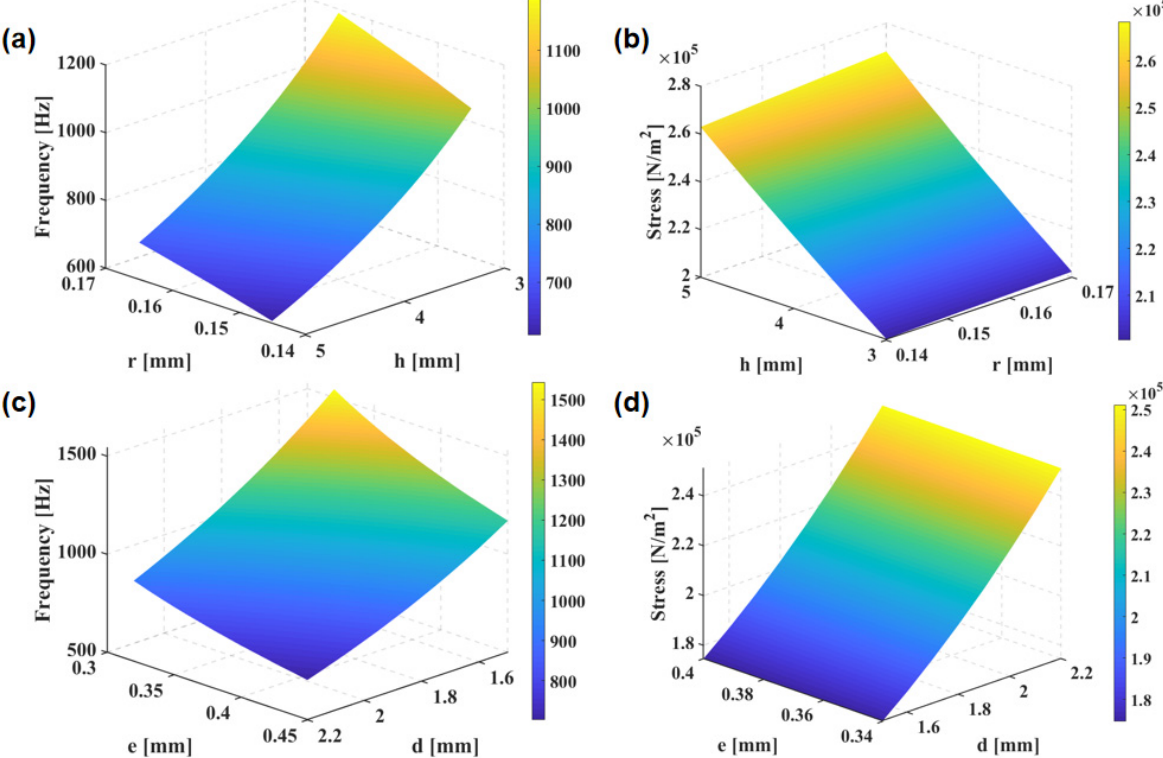
Figure 5. ( a ) Effects of radius r and height h on the first-order solid frequency; ( b ) effects of height r and radius h on the maximum beam stress; ( c ) effects of the concave diameter b and the concave cilium width t on the first-order solid frequency; ( d ) effects of concave diameter b and concave cilium width t on the maximum stress on the beams.